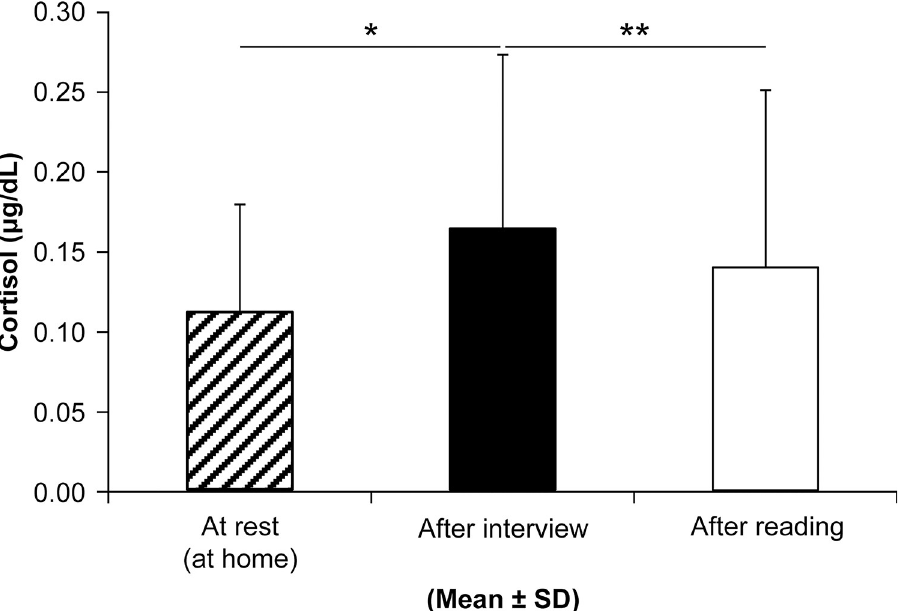
Fig 4. Salivary cortisol measurements. Saliva was collected three times. The first sample was collected within the same time frame as that of the interview but on a different day while the subjects were at home resting. The second sample was collected after the interview, and the third one was collected after the subjects had read a magazine. Salivary cortisol levels after the interview were significantly higher than those at baseline ( � p < 0.05) and those while the subjects were reading ( �� p < 0.01, after Bonferroni